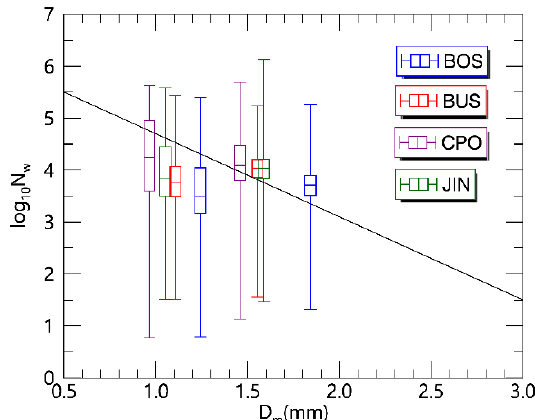
Figure 10. Boxplot of Dm and logNw values of convective and stratiform rain for each site. The line curve represents the separation line of rain types proposed by BR09. The section above (below) this line represents convective (stratiform) rain.